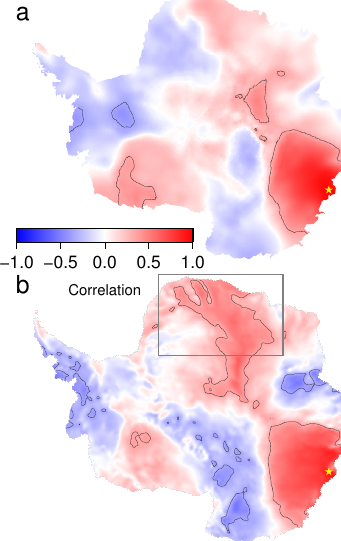
Figure 11. Spatial correlation maps for (a) ERA-Interim precipitation–evaporation (Dee et al., 2011) for 1979–2013CE and (b) RACMO2.1/ANT surface mass balance (Lenaerts et al., 2012) for 1979–2010CE. Contours show the 95% confidence level while yellow stars denote the location of DSS and the grey box shows Queen Maud Land.